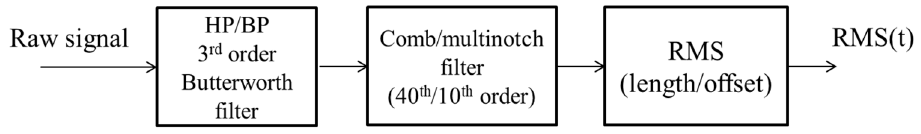
Figure 8. Diagram of the proposed EMG signal processing method with low computing power demand.